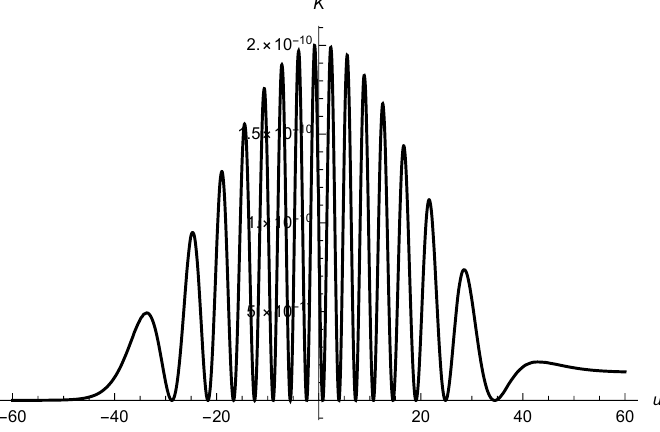
Figure 7. K ( u ) , considering H 1 , the initial conditions III and λ =